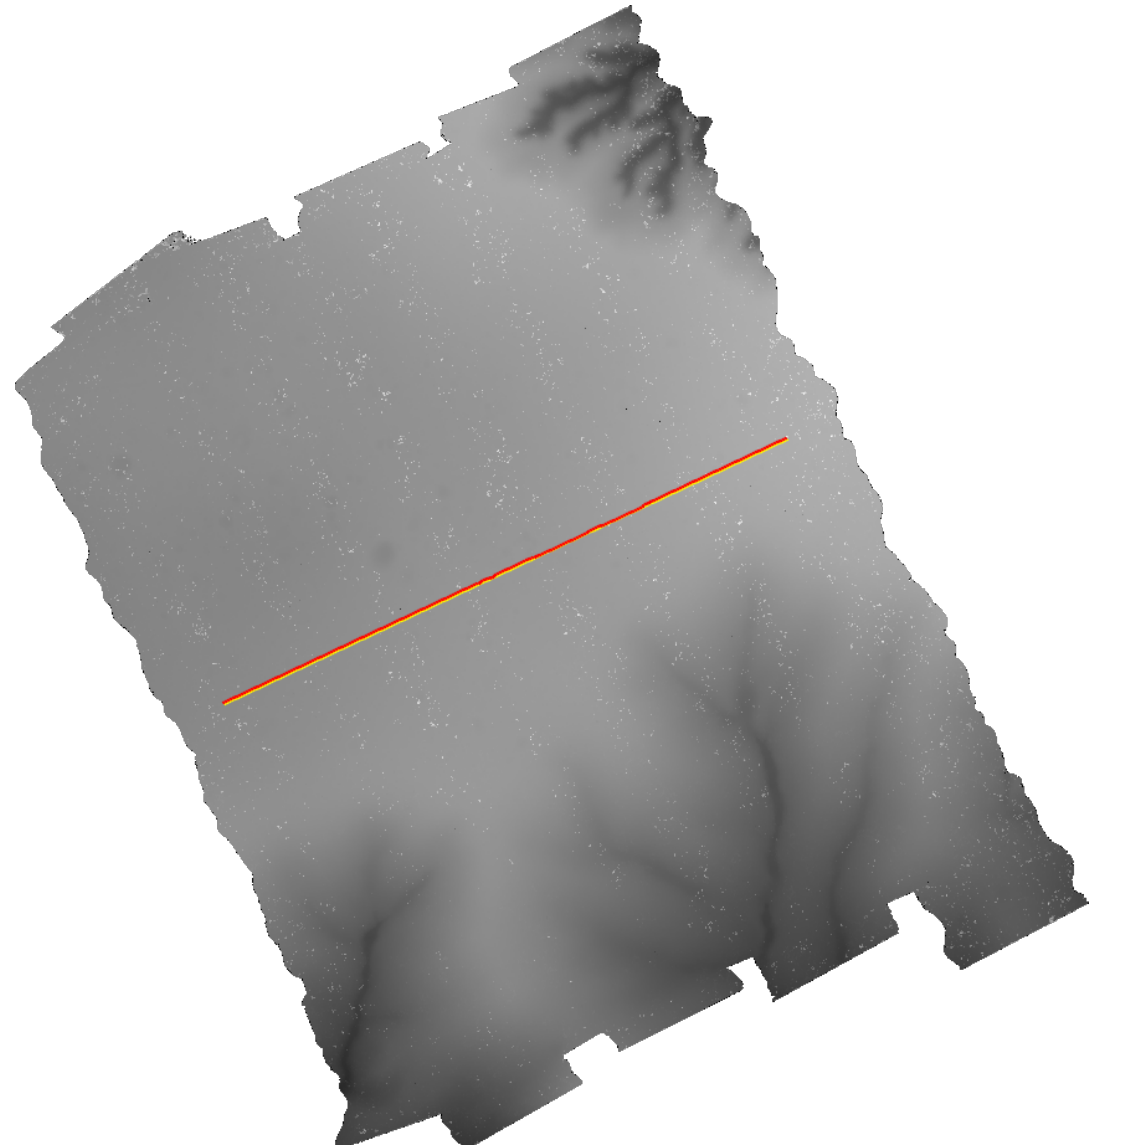
Figure 19. Trajectory in yellow on combined intensity, surface and terrain (joint), square bin, experi- ment. Corresponding estimated positions are drawn in red. Drawn over the terrain